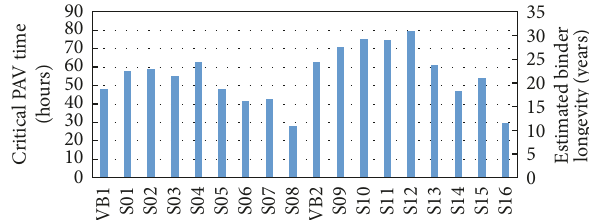
influence on the rate of aging and the critical PAV time. VB1 aged faster than VB2, and its aging was more influenced by rejuvenators.